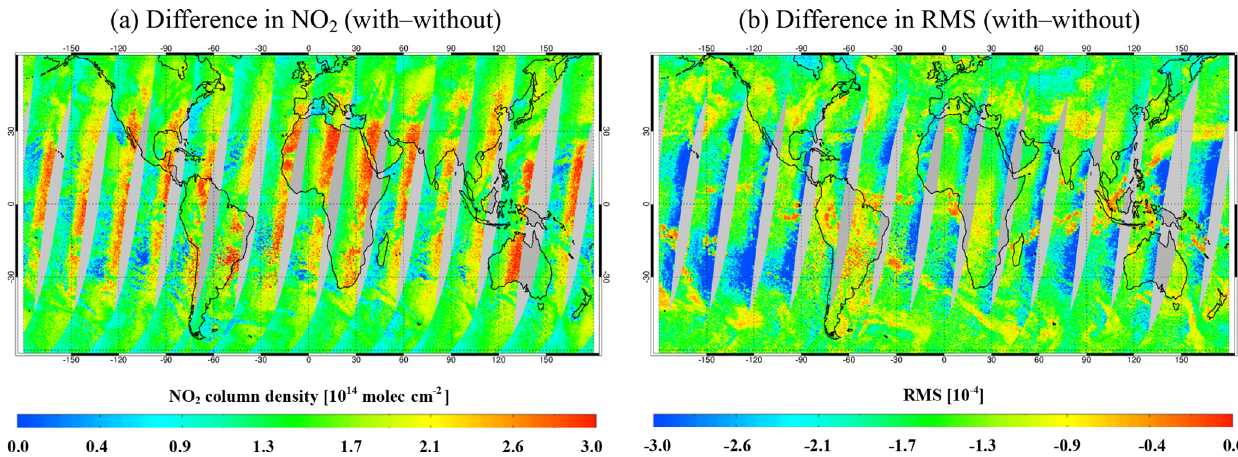
Figure 1. Difference in NO 2 columns (slant columns scaled by geometric AMFs) (a) and retrieval rms (b) estimated with and without a linear intensity offset correction for GOME-2A on 3 March